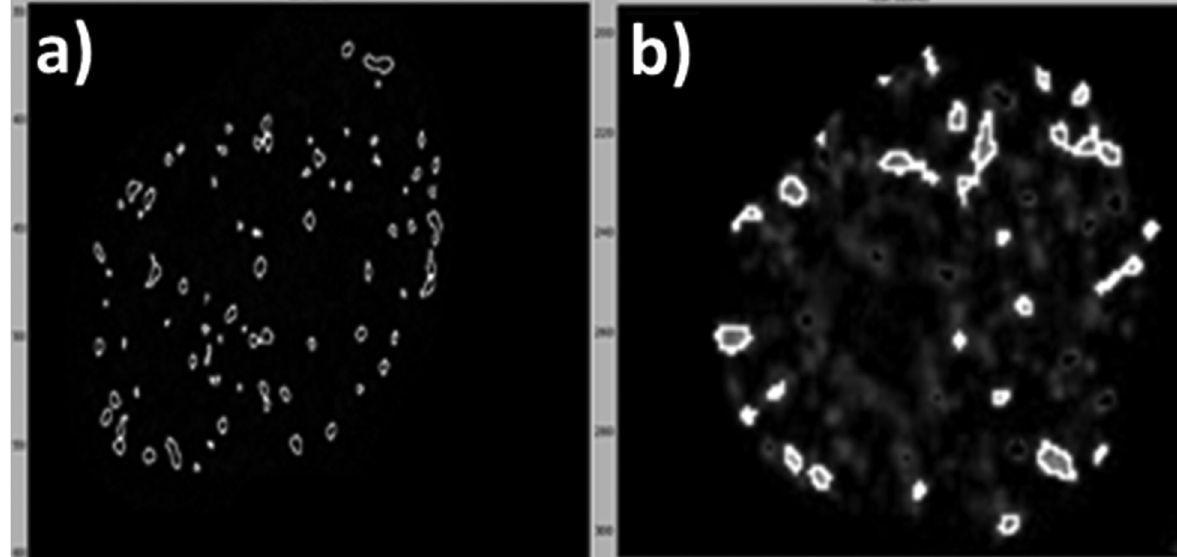
Figure 8 - Illustration of differences in counting of γ H2AX foci per HTB140 cell nucleus irradiated with 8 Gy γ -rays, obtained by the microscopes AxioVision comprising ApoTome software ( a ) and AxioImagerA1 ( b ). Objects of interest were outlined using CellPro fi ler image analysis software that was optimized for the